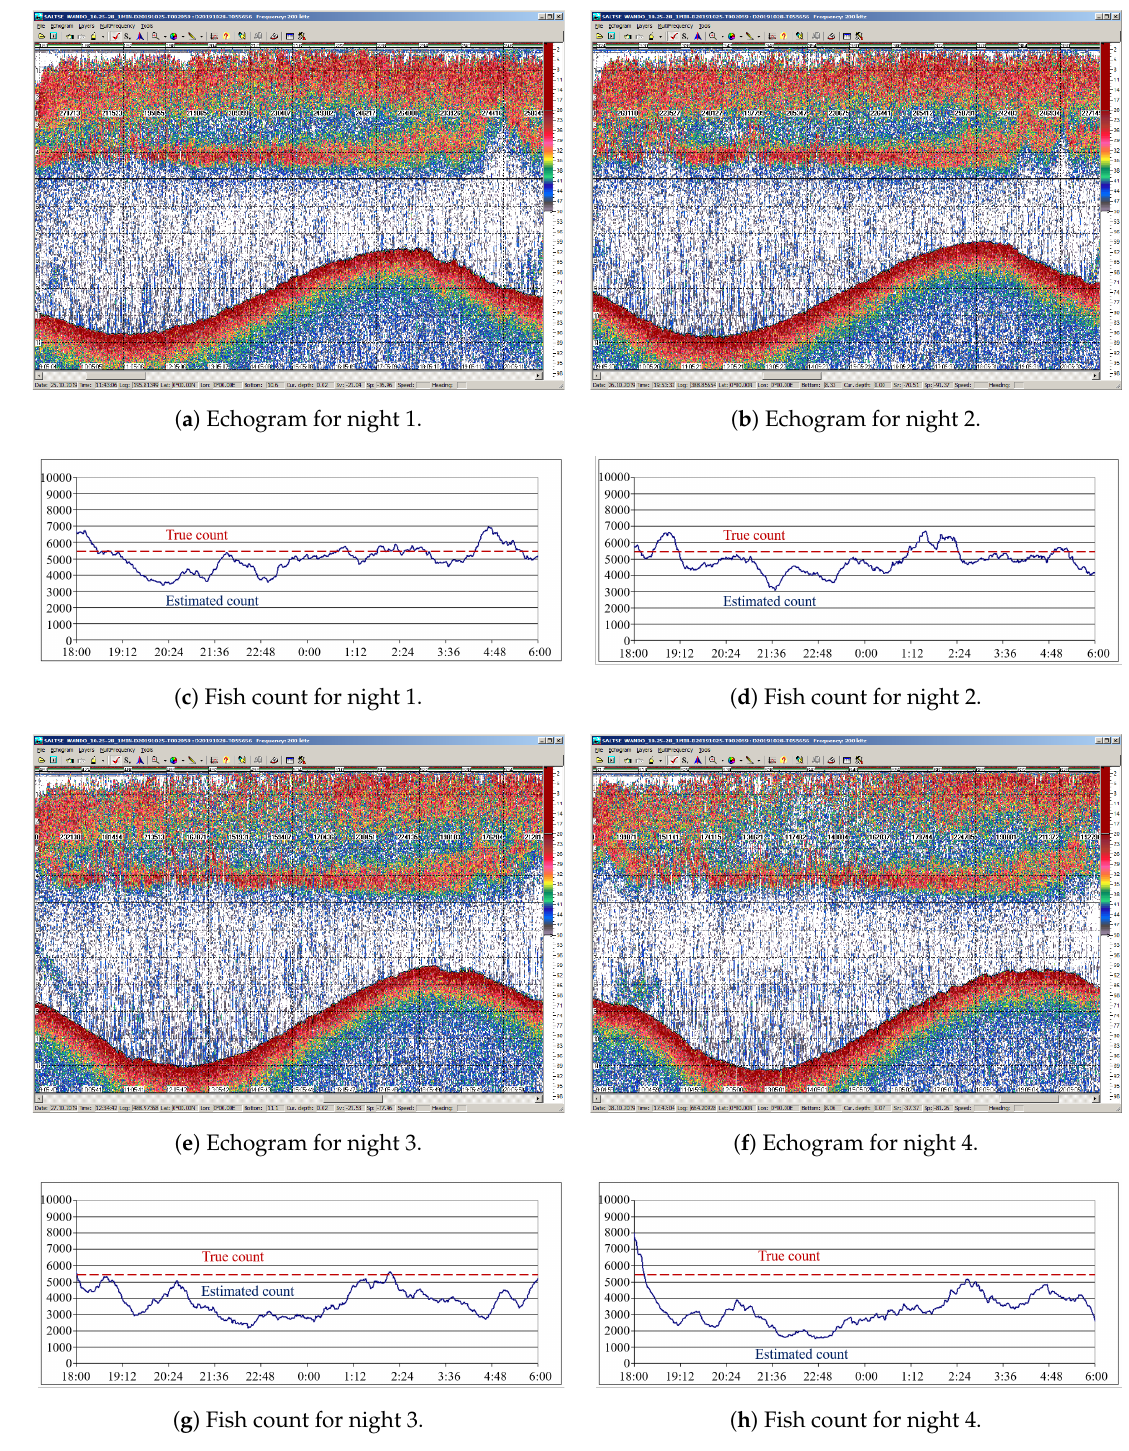
Figure 5. Echogram and fish estimation at night time from the 92 h experiment performed in